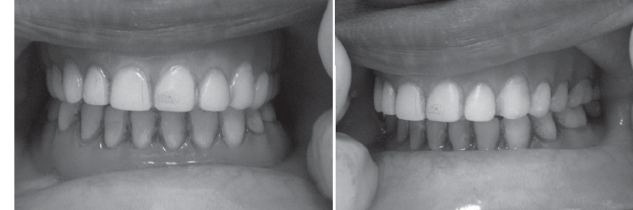
Fig. 6 : Frontal and lateral intraoral views of the patient with the dentures at the 12- month follow-up visit.